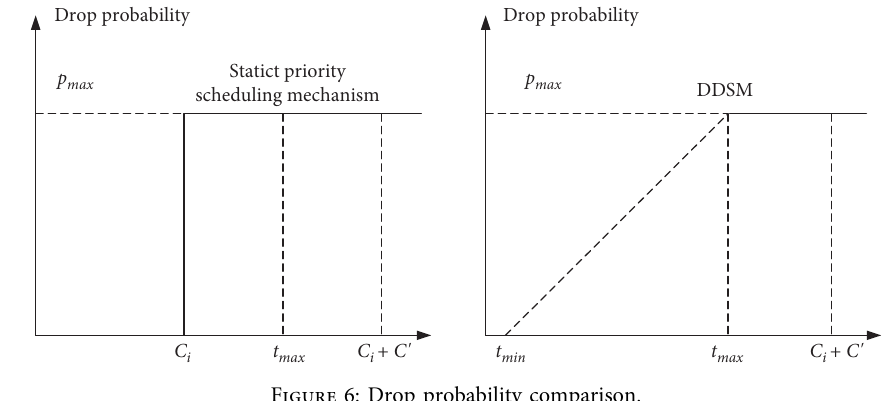
Figure 6: Drop probability